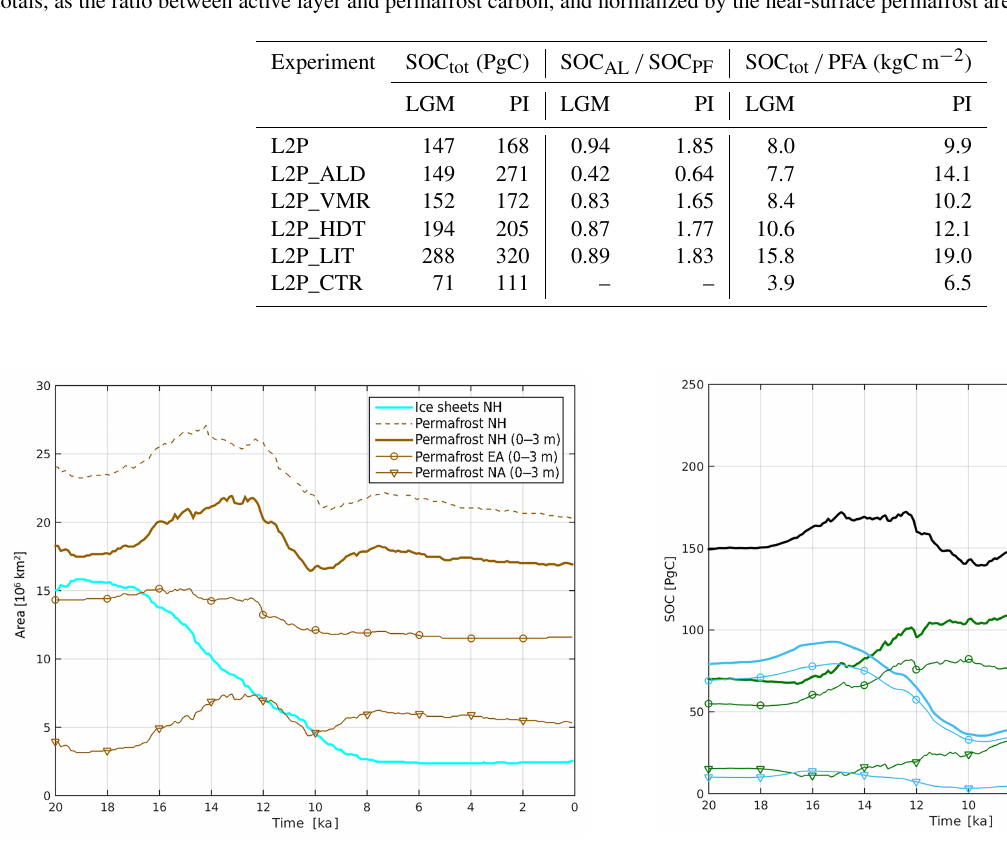
Figure 6. Deglacial evolution of simulated permafrost extent and prescribed ice sheet area from LGM to PI. Permafrost extent (brown lines) is shown separately for total (dashed line) and near-surface (solid line) Northern Hemisphere (NH) permafrost, subdivided into North America (NA, line with triangles), and Eurasia (EA, line with circles). Data shown represent 100-year time averages.